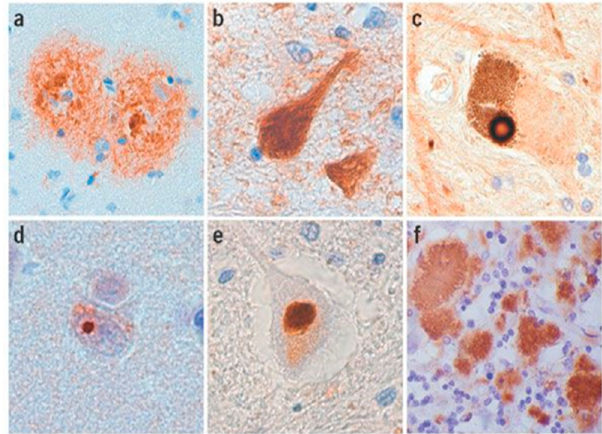
Figure 3. Atomic resolution structure (0.5 Å) of cross- β -amyloid fibrils formed by an 11-residue fragment of the protein transthyretin. The fibrils have the classic amyloid morphology and are 100– 200 Å in diameter and 1–3 μ m in length. Highly ordered cross- β -core structures are composed of arrays of ß-sheets running parallel to the long axis of the fibrils. ( A ) The background image of the fibril taken using TEM (scale bar—50 nm). ( B ) Magic-angle spinning nuclear magnetic resonance (MAS NMR) atomic-resolution structure of the triplet fibril fitted into the cryo-EM reconstruction. ( C ) The fibril surfaces with the constituent ß-sheets in a ribbon representation. Oxygen-red, carbon-gray, nitrogen-blue. The images were reconstructed using a combination of several biophysical techniques: X-ray fiber diffraction, cryoelectron microscopy, scanning TEM and atomic force microscopy. Other details are provided in [21].